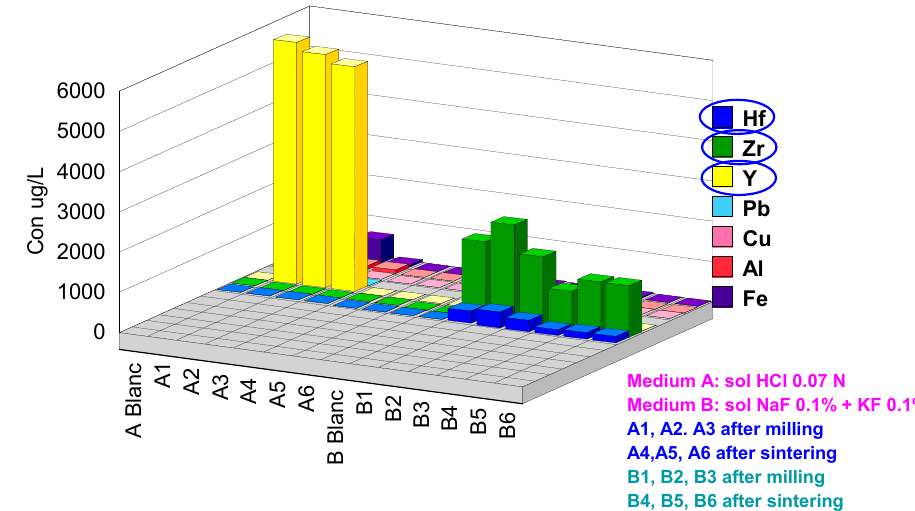
Figure 5. Cations released in the thousandth µ g / L scale.